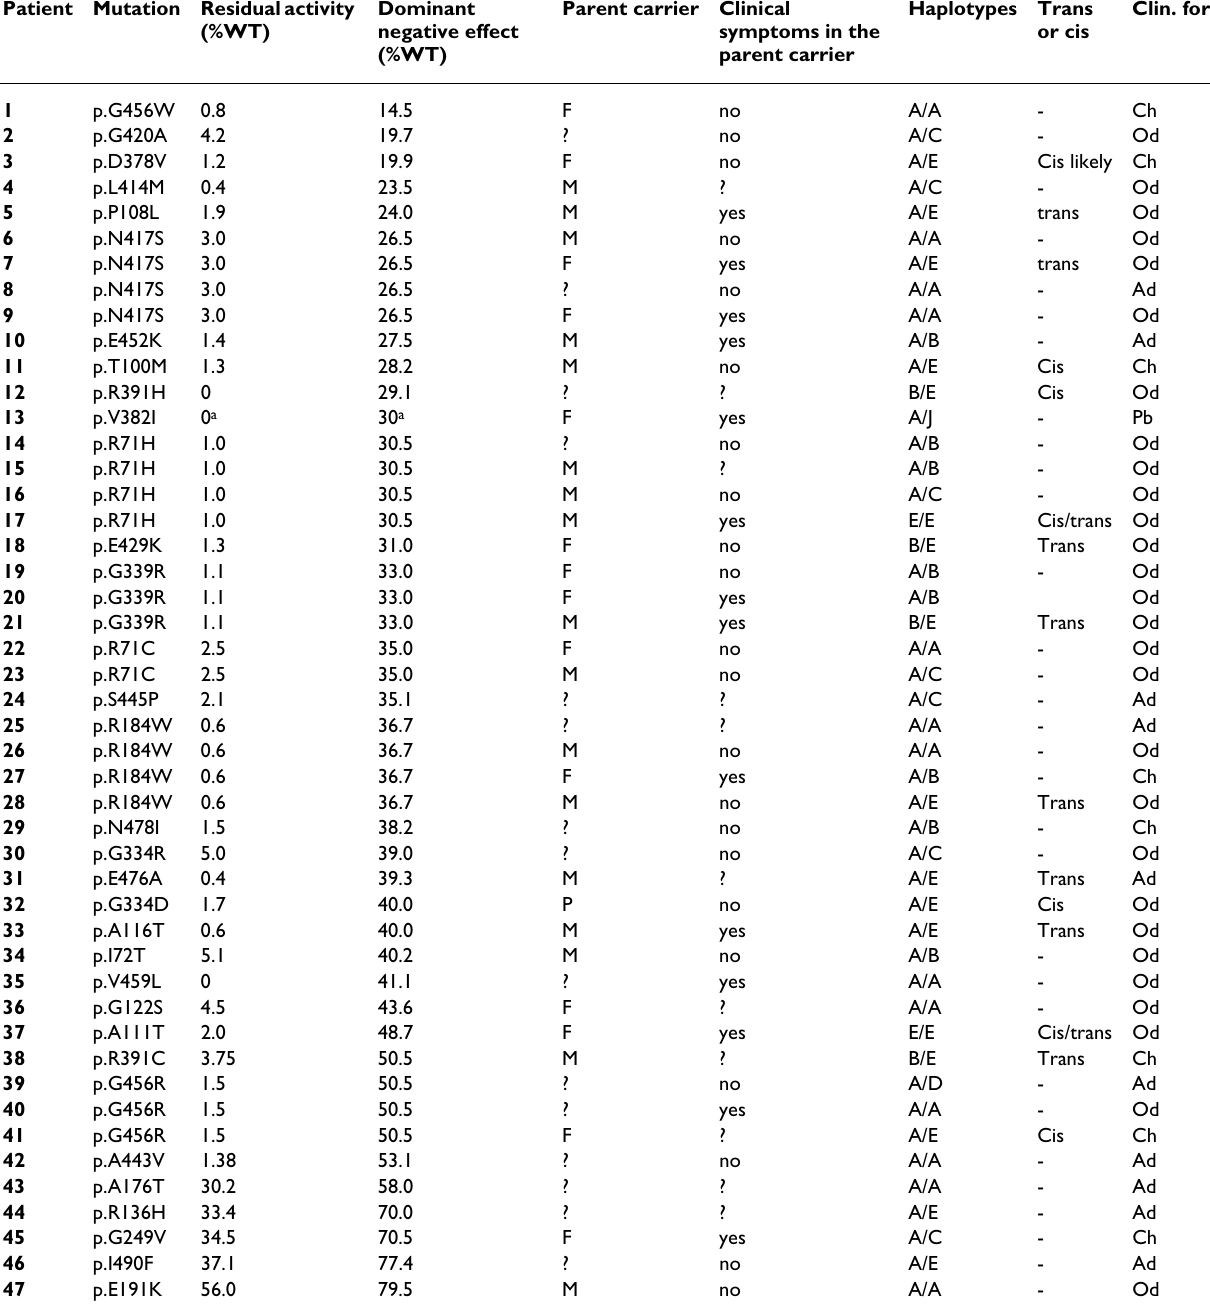
Table 3: The mutations found in patients carrying only one heterozygous mutation. Patient Mutation Residual activity